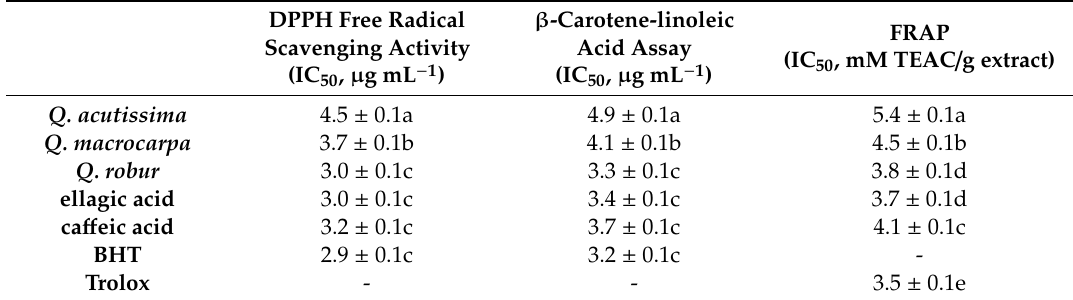
Table 2. DPPH and β -carotene bleaching acid of Q. acutissima , Q. macrocarpa and Q. robur outer bark extracts as well as phenol standards. Values are expressed as mean of triplicate determinations ± SD.